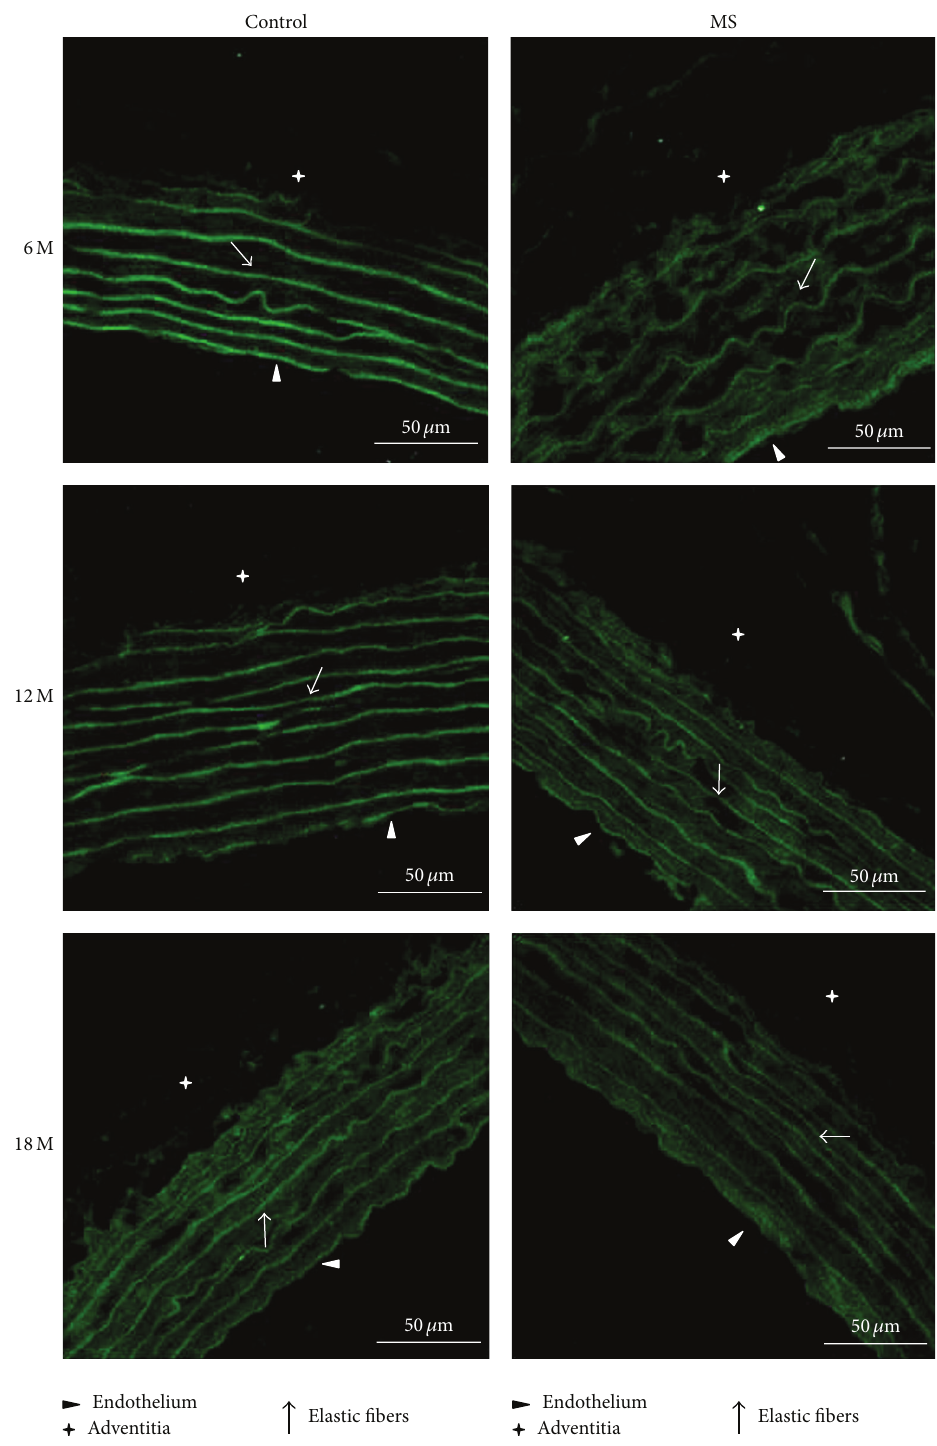
Figure 4: Illustrative images ( × 60) showing receptor AT2 immunofluorescence in aortas of control and MS rats aged 6, 12, and 18 months. Preparations were stained with FITC. Scale bar = 50 𝜇